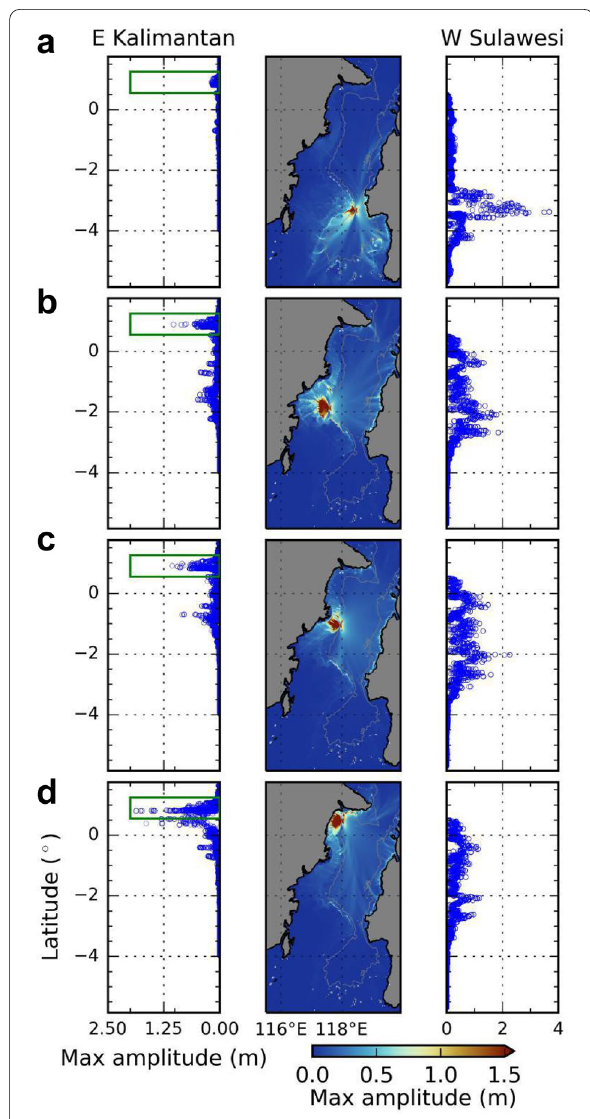
Fig. 7 Sensitivity study of the SMF distance from the coast when the SMF-5 km 3 is moved from the south ( a ) to north ( d ) along the contour depth of 1,500 m. SMF stands for Submarine Mass Failure. Green box shows Mangkalihat